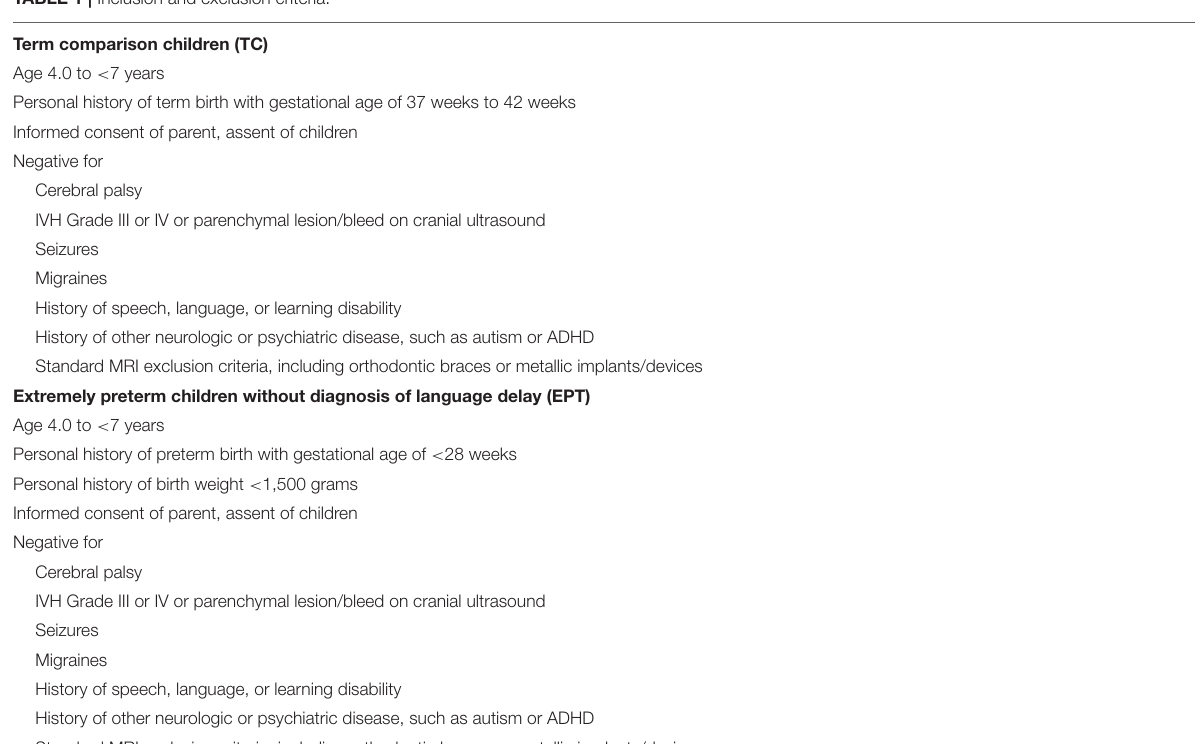
TABLE 1 | Inclusion and exclusion